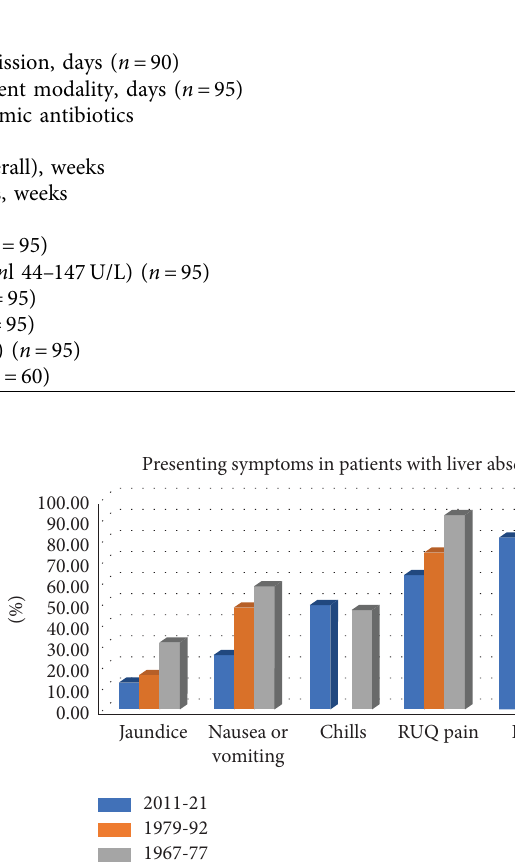
Figure 1: Presenting symptoms among patients with PLA in three consecutive cohorts in Jerusalem, Israel. Table 2: Comparison of the clinical features, diagnosis, management, and outcome of PLA in